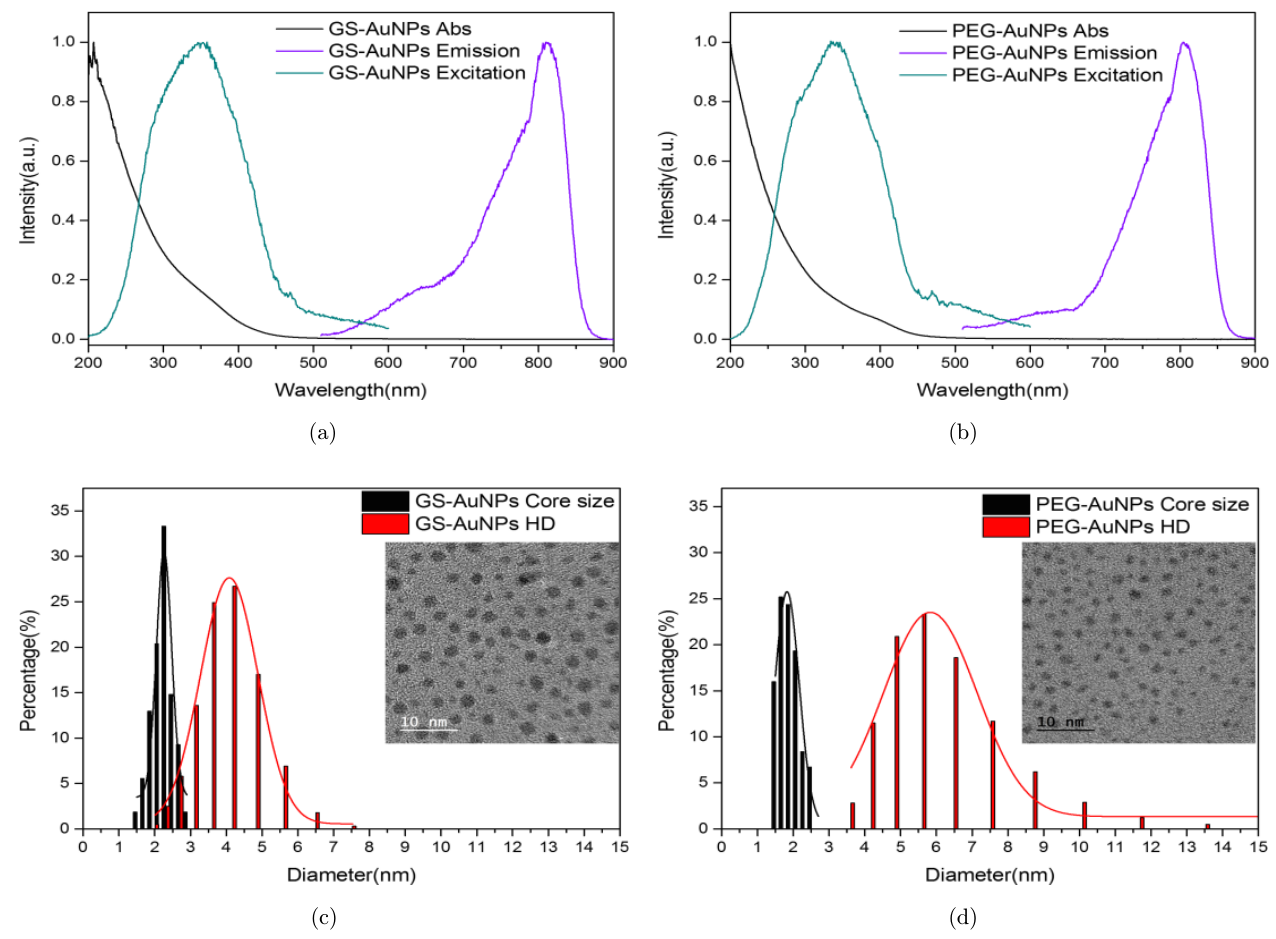
Fig. 1. Characterizations of GS-AuNPs and PEG-AuNPs. Normalized absorption, excitation and emission spectra of GS- AuNPs, (a) and PEG-AuNPs, (b) Core size and HD of GS-AuNPs, (c) and PEG-AuNPs (d); inset is the corresponding AuNPs TEM